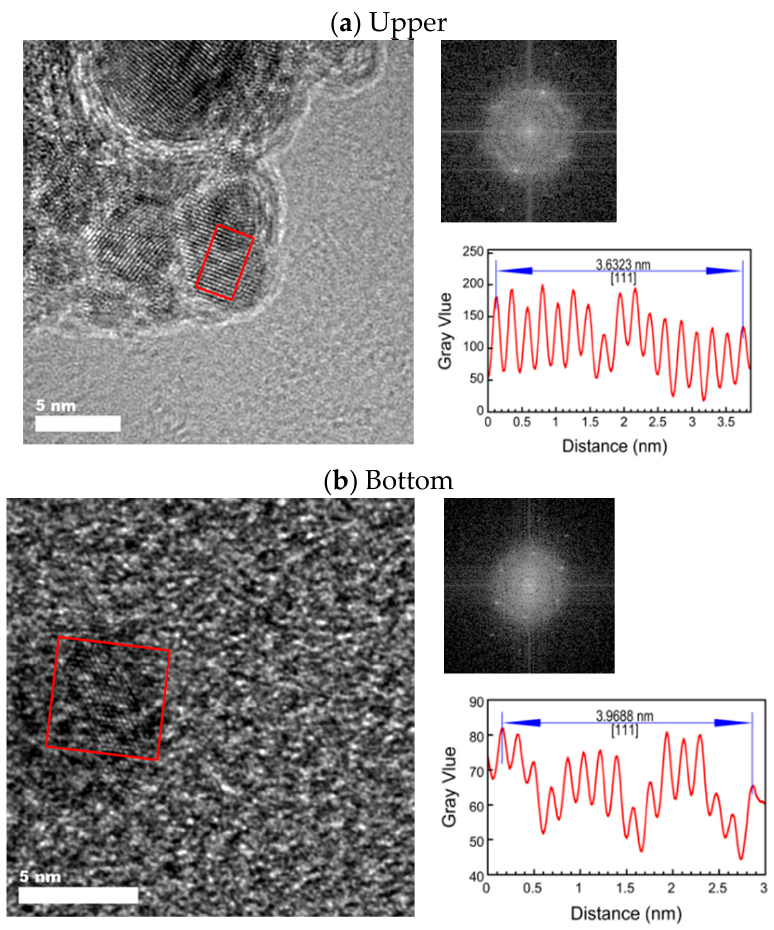
Figure 6. HR-TEM images of upper ( a ) and bottom ( b ) 1:1 Pd-Fe alloy nanoparticles with FFT pattern and surface spacing in the region enclosed in red.